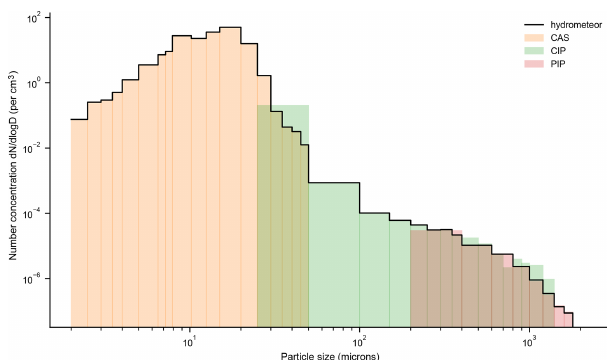
Figure 7. Size distributions for the CAS, CIP, and PIP (colored rectangles) along with the merged hydrometeor distribution (black line) synthesized from all three instruments. The figure demonstrate the re-binning described in the text. The figure shows data from a single cloud pattern leg on 5 February 2020 from 19:51:48 to